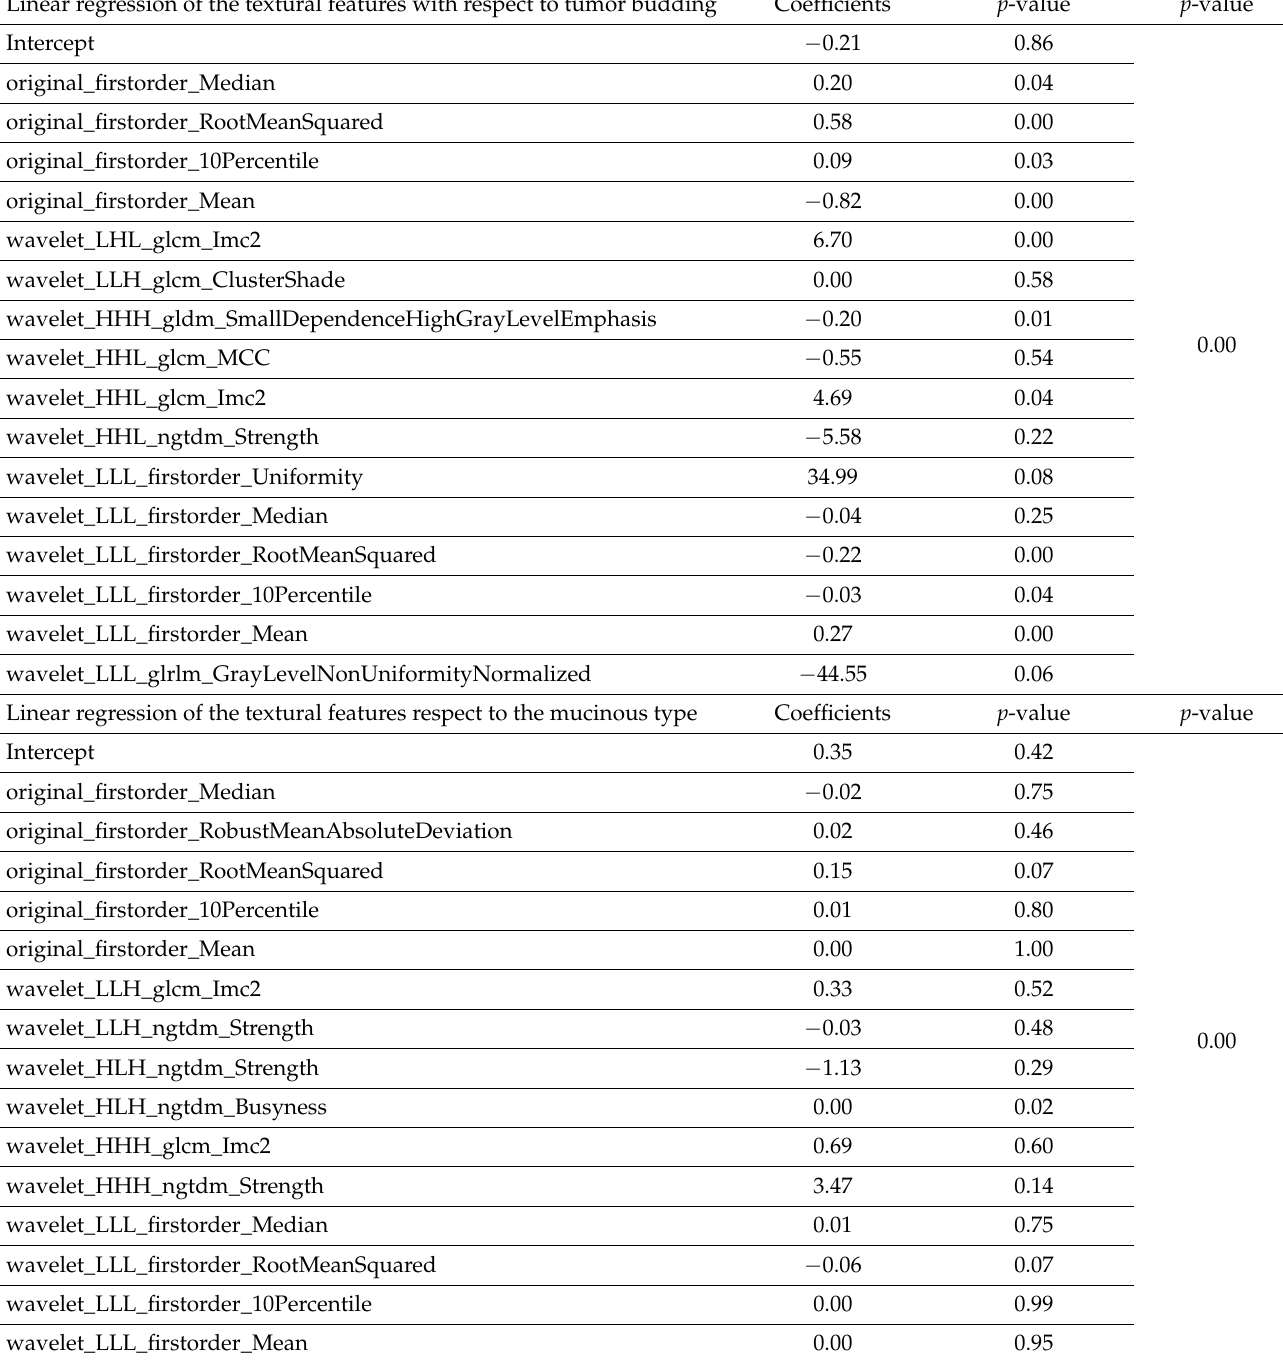
Linear regression of the textural features with respect to tumor